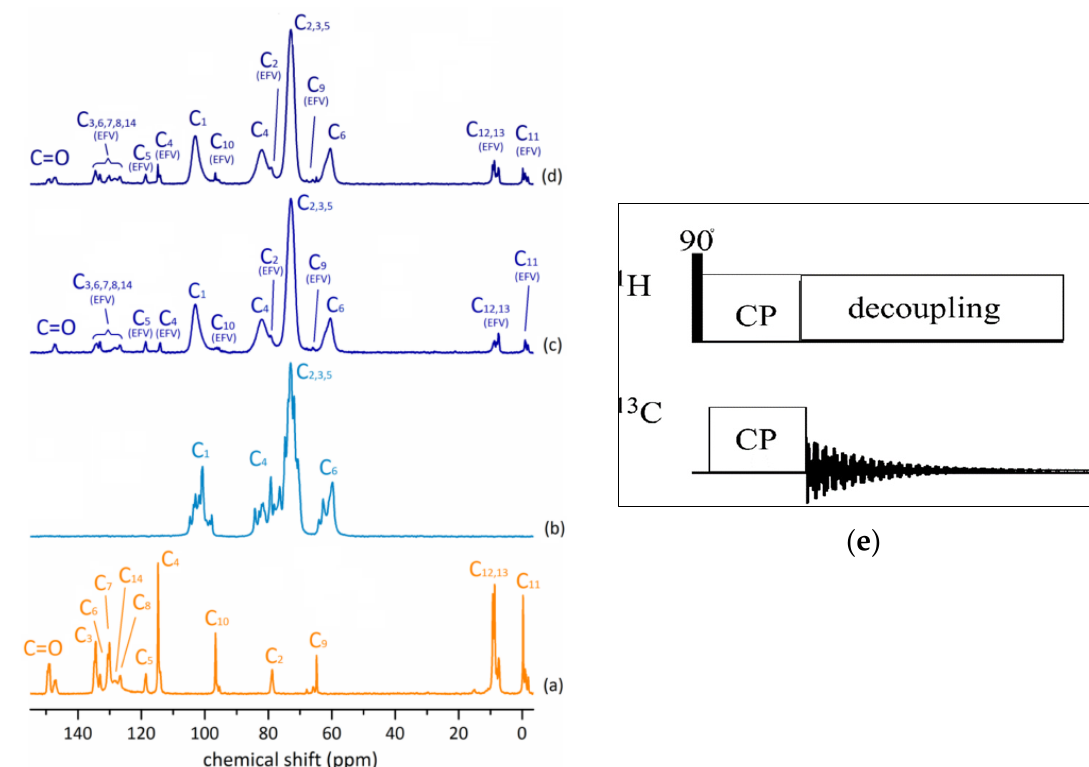
Figure 3. 1 H → 13 C CP-MAS NMR spectra of ( a ) Efavirenz (EFV), ( b ) γ -CD, ( c ) ( γ -CD) 3 @(EFV) 2 , and ( d ) γ -CD@EFV. Adapted from [55], licensed under CC BY 4.0. ( e ) Image on the right presents 1 H → 13 C CP NMR pulse